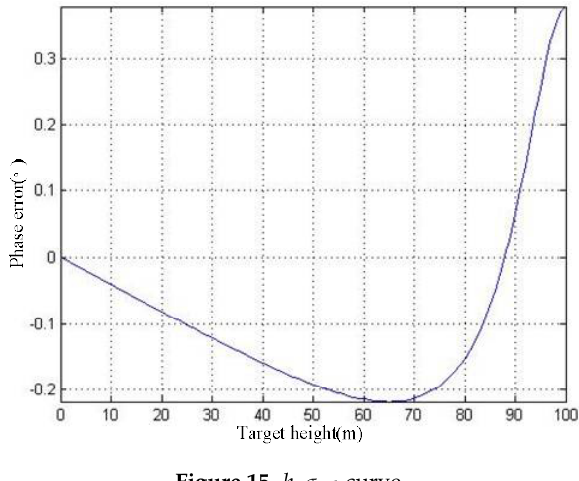
Figure 15. h – σ pd curve.